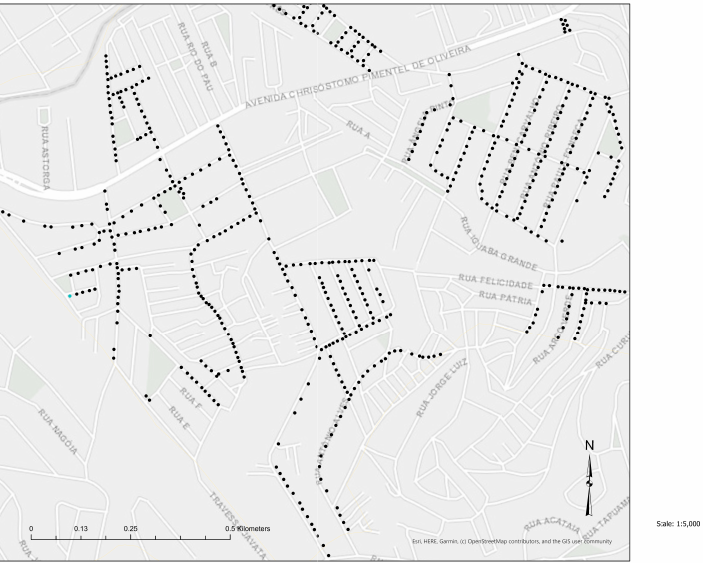
Figure 6. Pavuna’s secondary streets are very narrow, so MPT’s were located only on one side of the